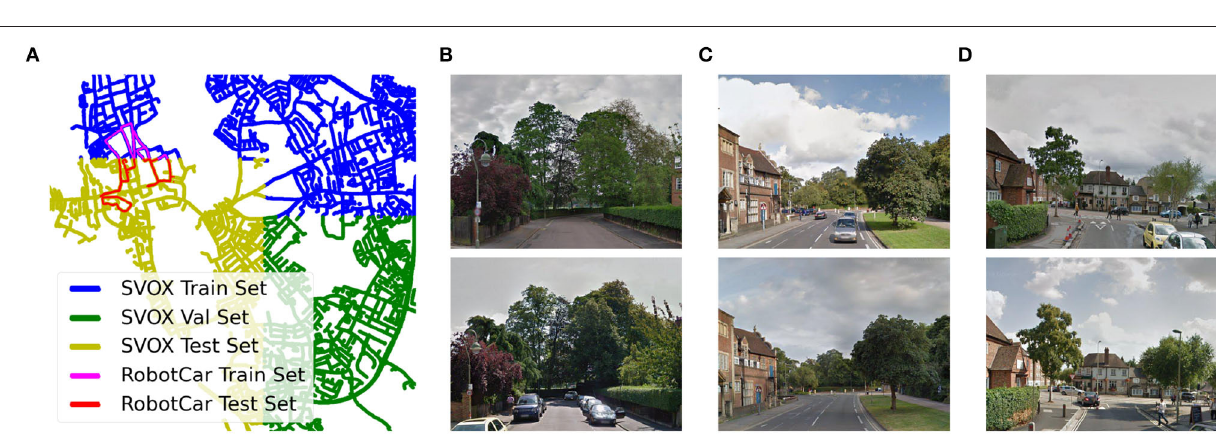
FIGURE 2 | (A) Area of the city of Oxford covered by SVOX and RobotCar (Maddern et al., 2017) datasets, respectively. (B–D) pairs of images collected from Google StreeetView Time Machine, which view the same places but in different years, demonstrating how long-term temporal variations lter the appearance of a